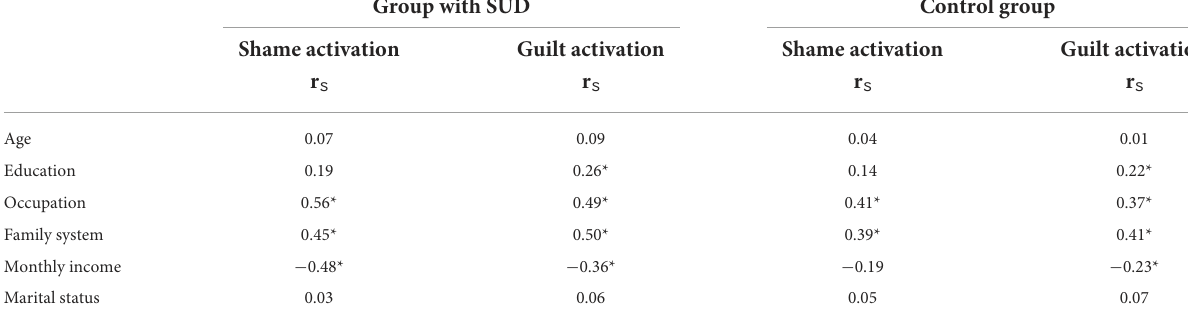
TABLE 2 Correlation of sociodemographic characteristics with shame and guilt-activation among group with SUD and control group. Group with